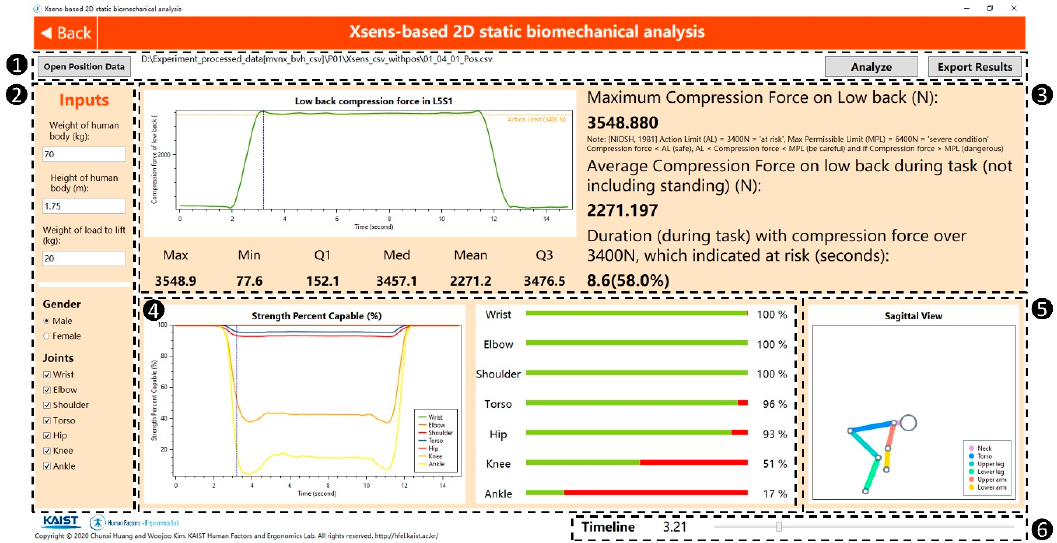
Figure 5. The GUI of the automated 2D static biomechanical analysis tool in the developed system. Numbers in black circles indicate the number of each section.